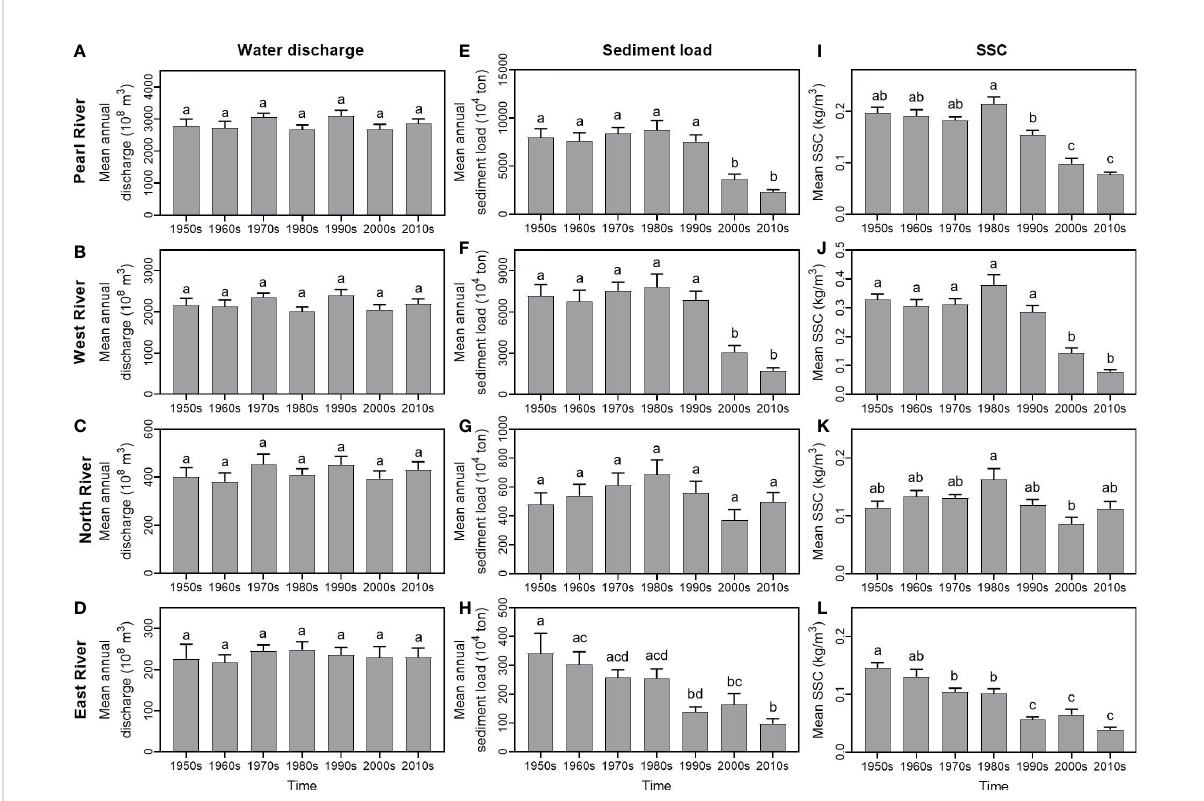
TABLE 4 The slope of liner regression between annual discharge, sediment load and suspended sediment concentration and time in the Pearl River as well as its major tributaries in different periods. Discharge Sediment load SSC (*10 3 )